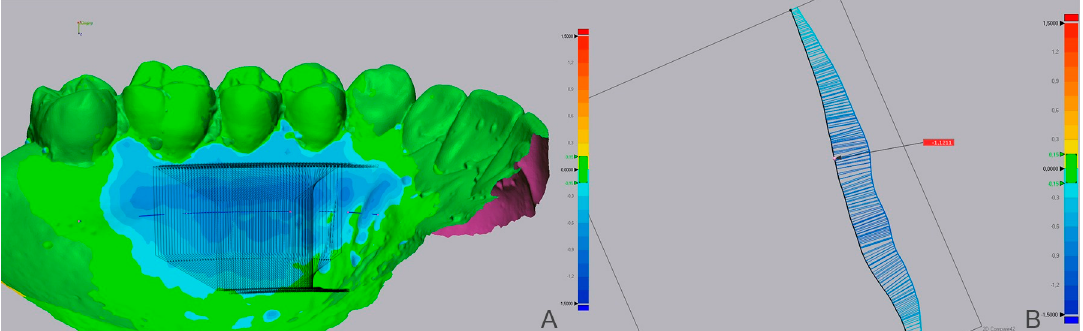
Figure 3. Case showing extensive tissue loss by the blue color. ( A ) Insertion of section plans perpendicular to ROI’s entire length. ( B ) Sagittal section and measurement of thickness loss points.